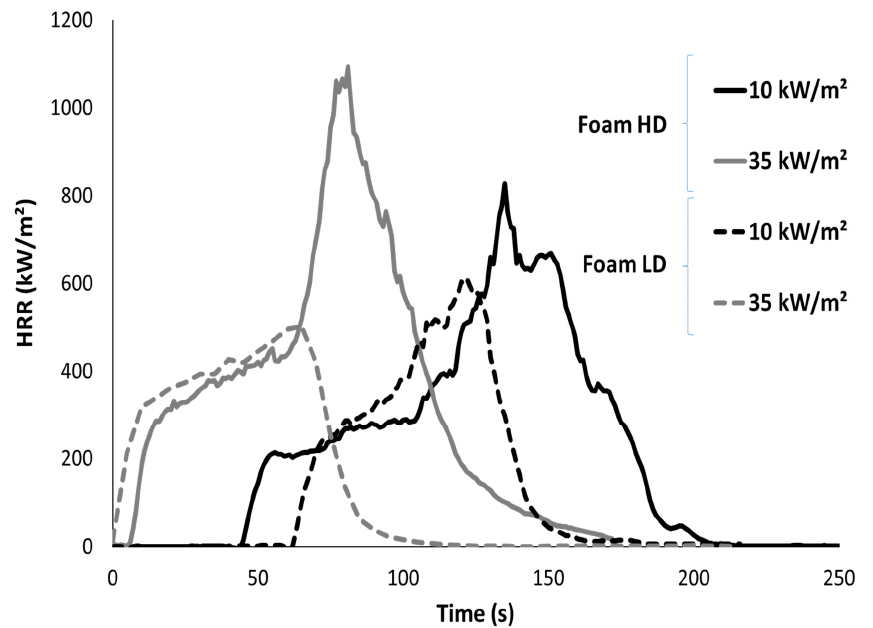
Figure 6. Heat release rate curves of both foams in cone calorimeter tests (sample thickness 10 cm). there is an almost constant ratio between the layer front rate at edge and at foam middle (ratio close to 2). Collapse was studied using a digital camera and an infrared camera. Pictures from the digital camera are shown in Figure 7 for HD foam at 35 kW/m 2 . Similar behaviour is observed for other foams and/or heat flux. As already identified by Kramer et al., a thin layer is formed at the surface constituted by melted material and black islets of char. The buoyancy of the surface is vigorous. The islets are more numerous for HD foam but they are not thermally stable. Therefore, no stable char layer is formed during the fire. At the end of the test, the residue yield is negligible. On the foam face recorded by the digital camera, the layer moves through the thickness and the layer front is parallel to the surface (yellow arrow), at least at the centre of the face. On the sides (see black arrow), the layer front progresses more quickly. It is probably due to the presence of aluminium foil. There is no close contact between the foil and the foam, and the aluminium foil may reflect the heat flux, allowing a faster heating of the foam. The collapse at the middle of the foam is slower. The following discussion is only based on the rate of front recession on the centre of the foam face (yellow arrow). Note that the rate of the front recession is constant during most of the collapse. Kramer et al. have shown that